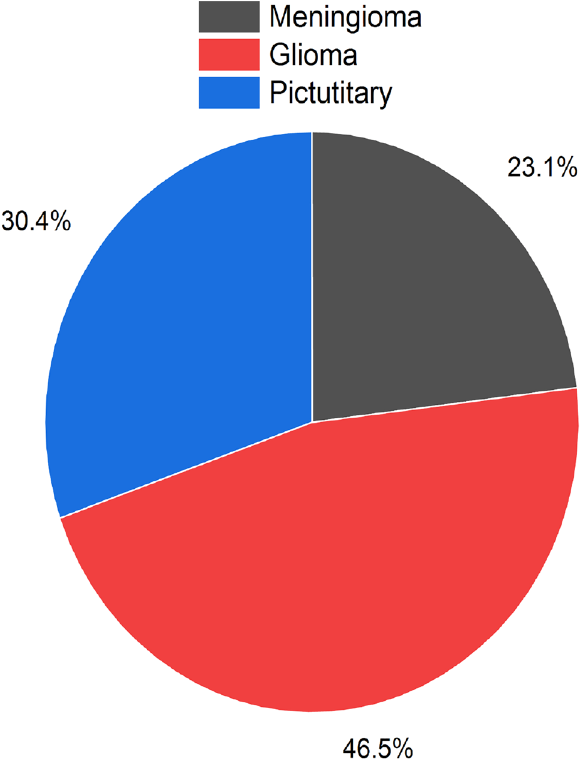
Figure 3. Ratio of samples in data set.